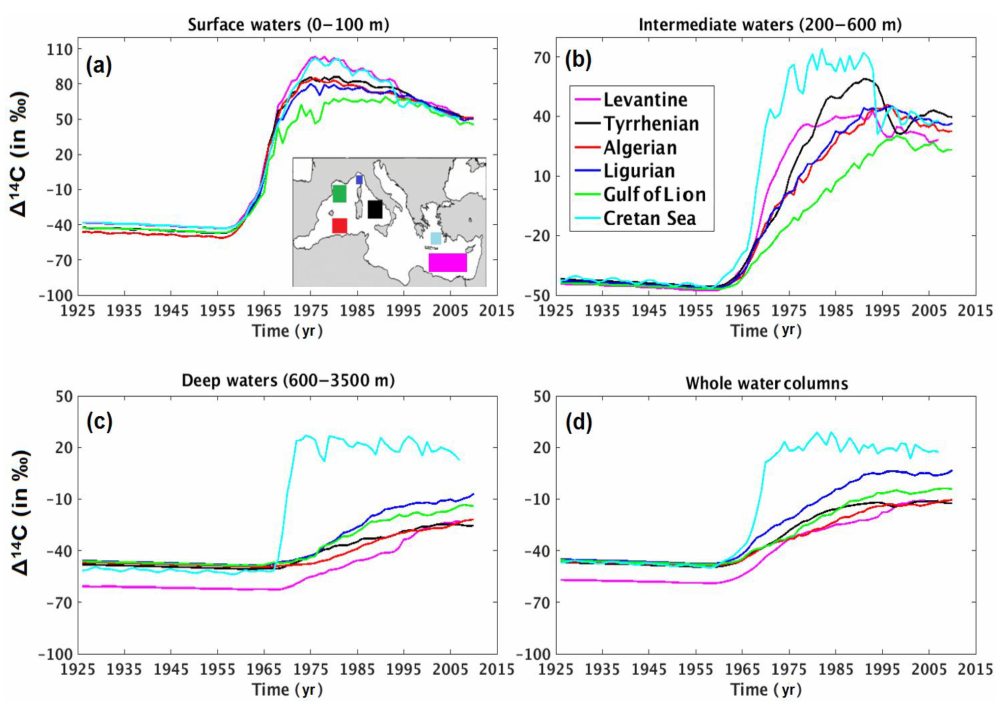
Figure 9. (cid:49) 14 C evolution from 1925 to 2008 in the Gulf of Lion (green), the Algerian sub-basin (red), the Levantine sub-basin (magenta), the Tyrrhenian sub-basin (black), the Cretan Sea (cyan), and the Ligurian sub-basin (blue).